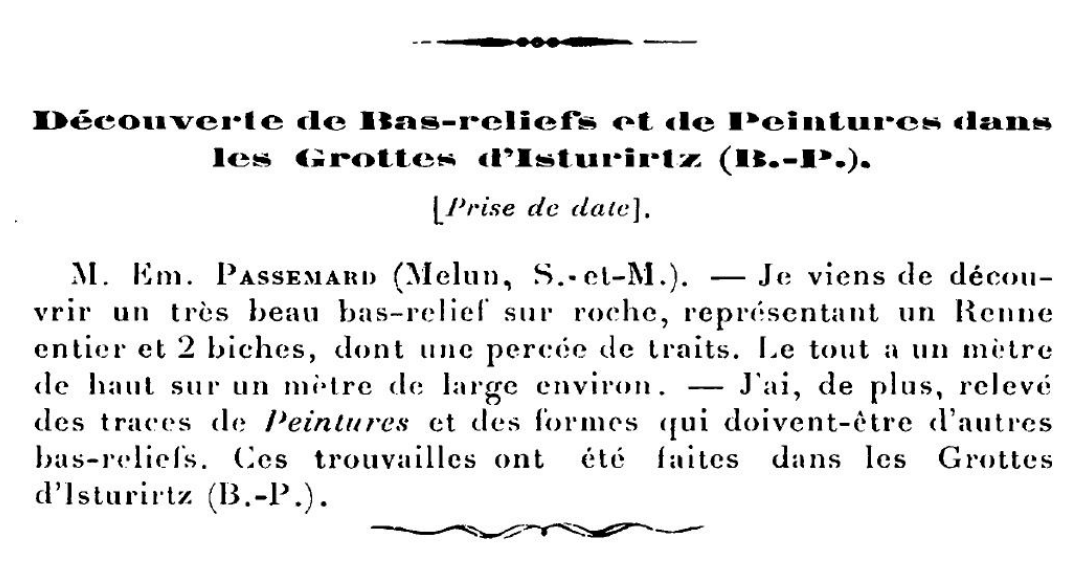
Figure 4. First reference to the parietal sculptures of the Isturitz cave (Passemard, 1913a)